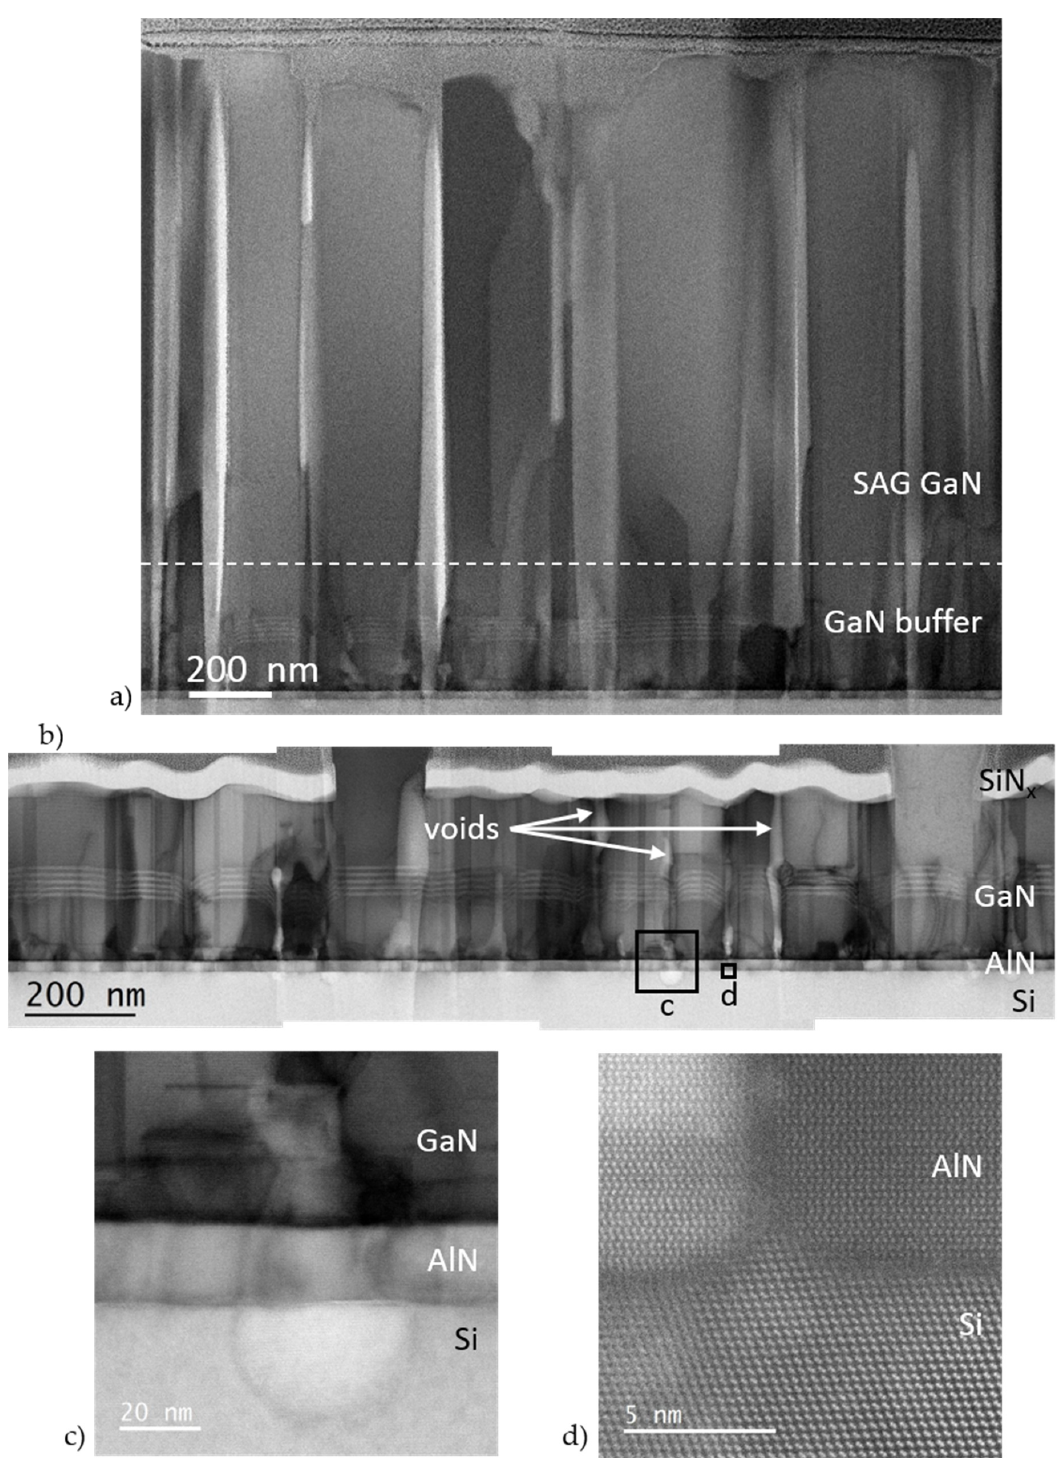
Figure 5. ( a ) through ( c ) STEM ABF images of the N–AlGaSL-2 buffer: ( a ) lower magnification image showing the columnar structure associated with the granularity observed in the SEM (Figure 2d,e), the dashed white line marks the interface between the GaN buffer and the SAG GaN; ( b ) lower magnification composite image showing columnar voids in the GaN buffer beneath the SiNx mask; ( c ) high magnification image of a void which initiates in the Si buffer (left box in ( b )); and ( d ) atomic scale STEM HAADF image at the base of another void (right box in ( b )) where the Si protrudes above the substrate plane and generates a defect in the AlN